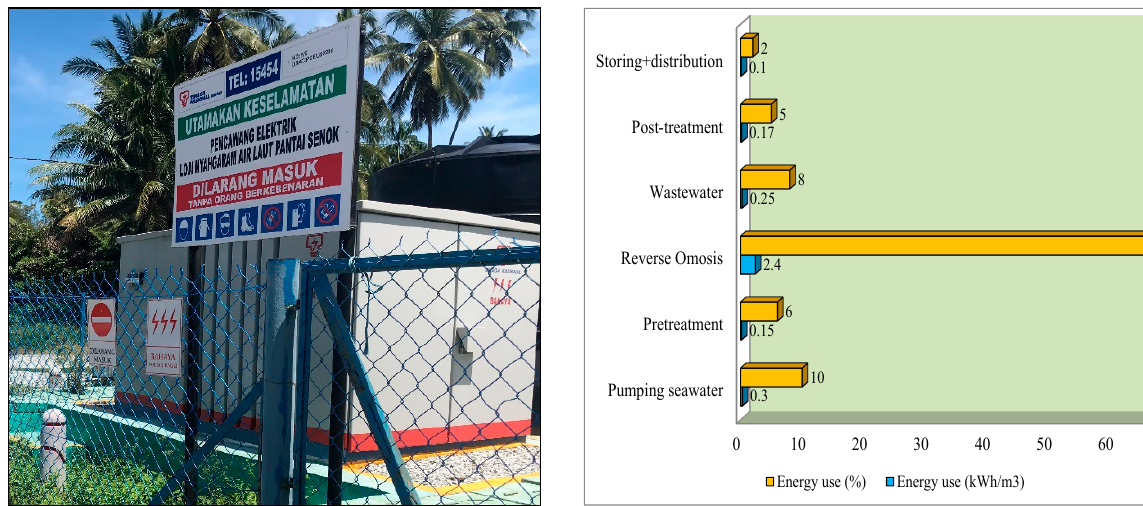
Figure 4. TNB’s electric power generating system covers the transmission and distribution of electricity, according to the SWRO process stage in Senok, Kelantan.